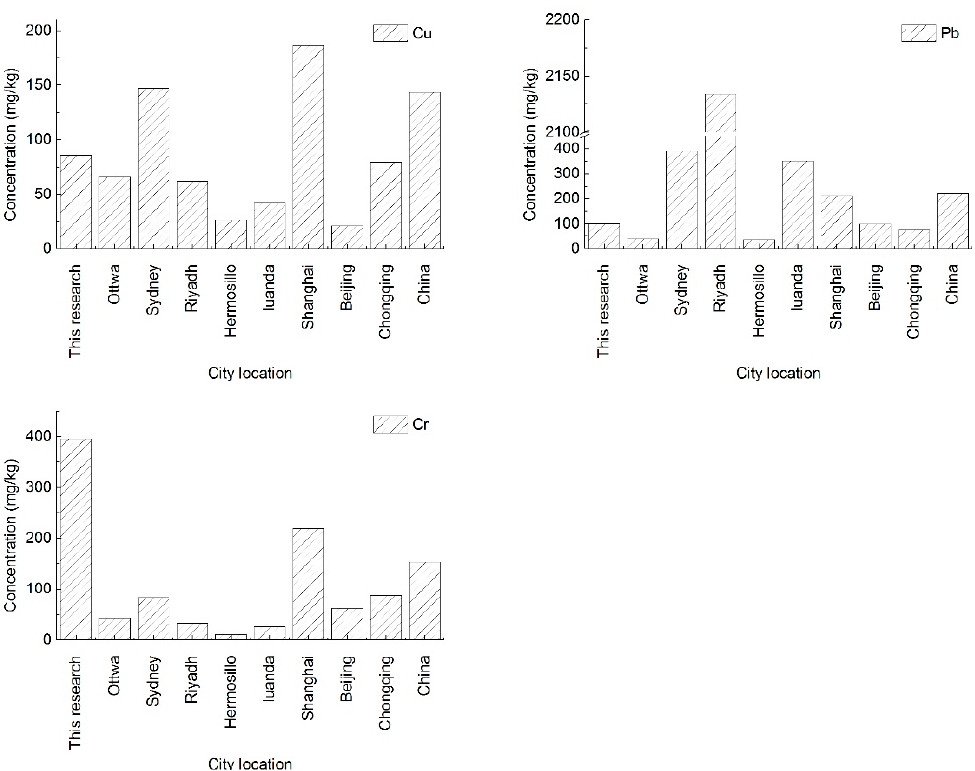
Figure 3. Comparison of the dust heavy metal contents in leisure squares of Yanta District of Xi’an with other cities.